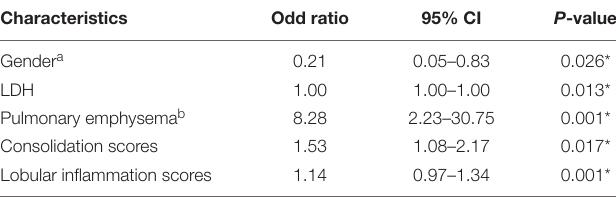
TABLE 2 | Multivariable logistic regression for nomogram construction. Characteristics